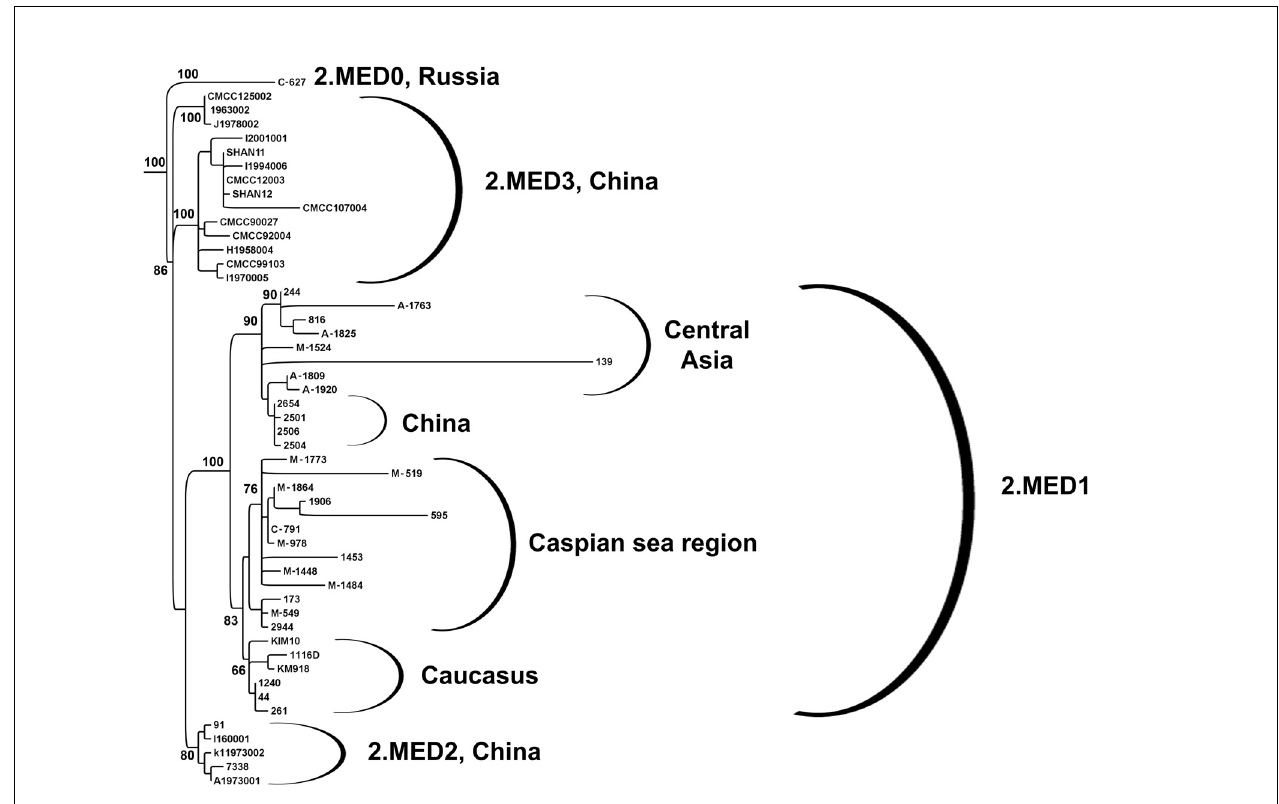
FIGURE 3 | Phylogenetic analysis of Y. pestis strains of 2.MED branch of medieval bv. from plague foci of CIS and neighboring countries (fragment of the global phylogeny dendrogram of Y. pestis, shown in Figure 2 ). Maximum likelihood tree, PHYML 3.1 software program, HKY85 model and 500 bootstrap replications. Strains M-1864 (43), M-978 (14), M-1773 (16), M-1484 (15), M-1906 (43), M-595 (43), C-791 (03), M-1448 (17), M-1453 (18), 173 (23), M-549 (20), and M-519 (26) are from plague foci of the Caspian Sea region of RF, Kazakhstan, Uzbekistan, and Turkmenistan; strains KM918 (01), KM919 (01), 1116D (02) 44 (08), 1240 (10), 261 (09) – from foci of Caucasus of RF, Azerbaidzhan; strains 244 (21), KM816 (25), A-1763 (24), 139 (29), A-1825 (27), M-1524 (23), A-1809 (40), A-1920 (30) – from foci of Central-Asian region (Kazakhstan, Uzbekistan, and Turkmenistan); other strains (NCBI GenBank) are from plague foci of China and Iran (strain KIM10). Each designation consists of the strain name followed by the number of plague foci in which they were isolated in parenthesis.